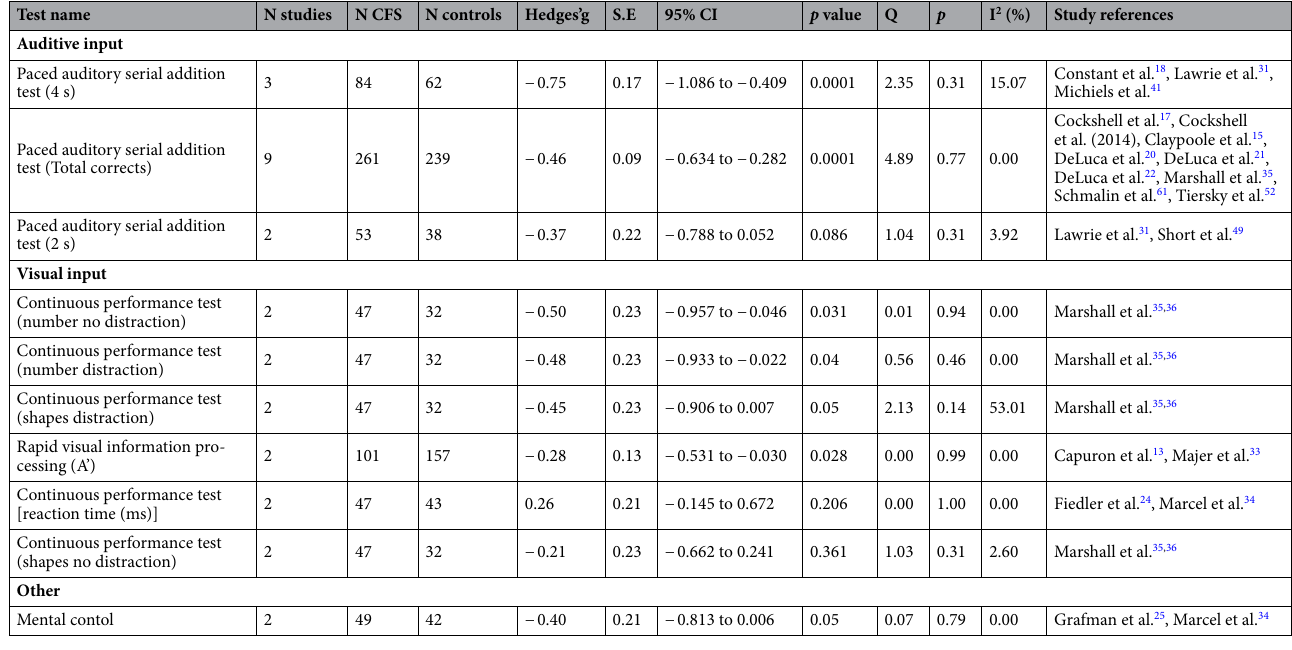
Table 6. Attention: Hedge’s g effect sizes for each test, in descending order. ME/CFS myalgic encephalomyelitis/chronic fatigue syndrome, N number.